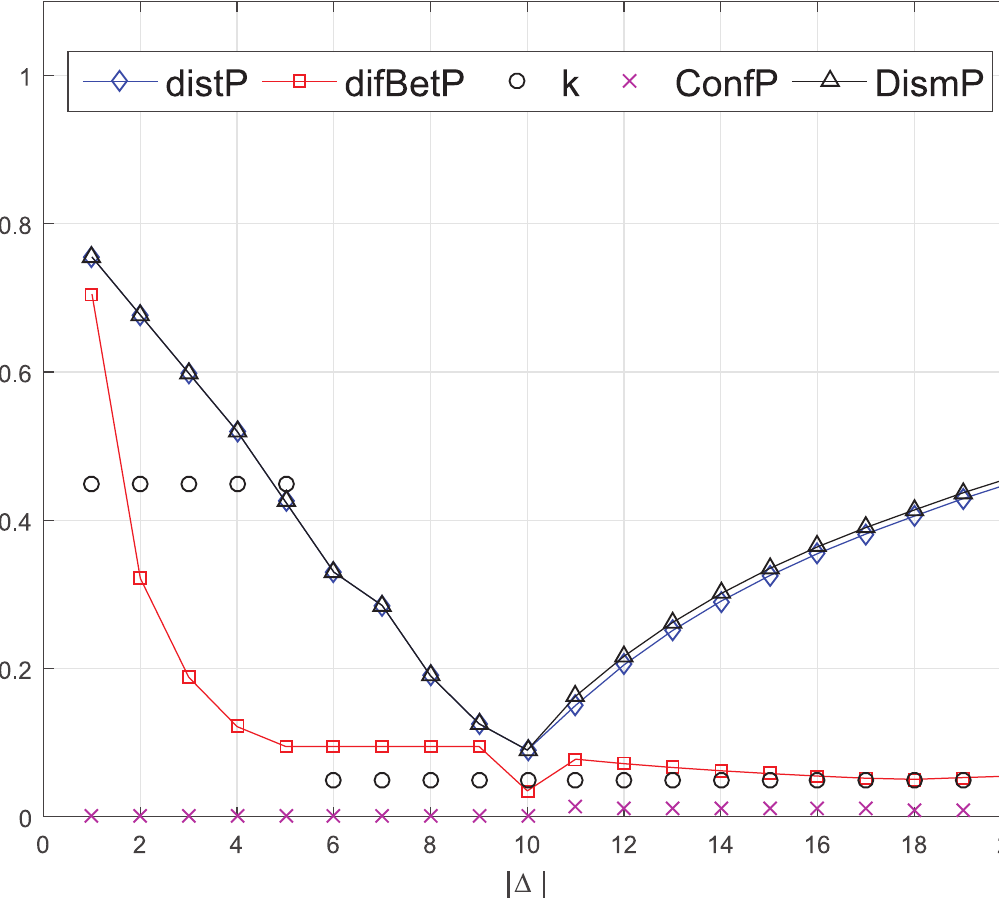
Fig 3. Comparison of dissimilarity measuresof the 2nd pair